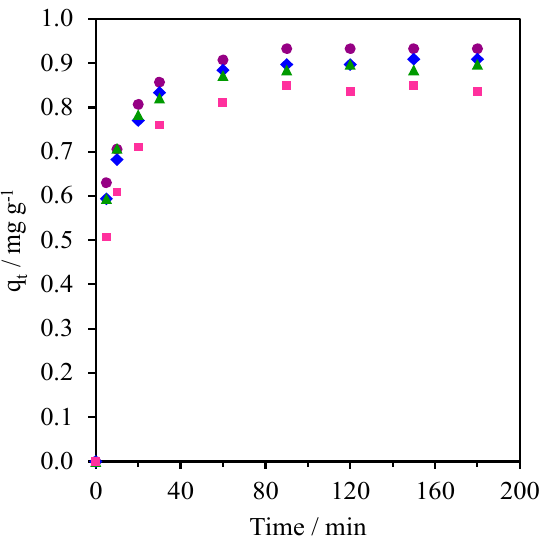
Figure 11. Reusability test of NR/WMS − 0.05 in the CFA removal from aqueous solution. ( ● ) Fresh, ( ▲ ) 1st Cycle, ( ⧫ ) 2nd Cycle and ( ■ ) 3rd Cycle.